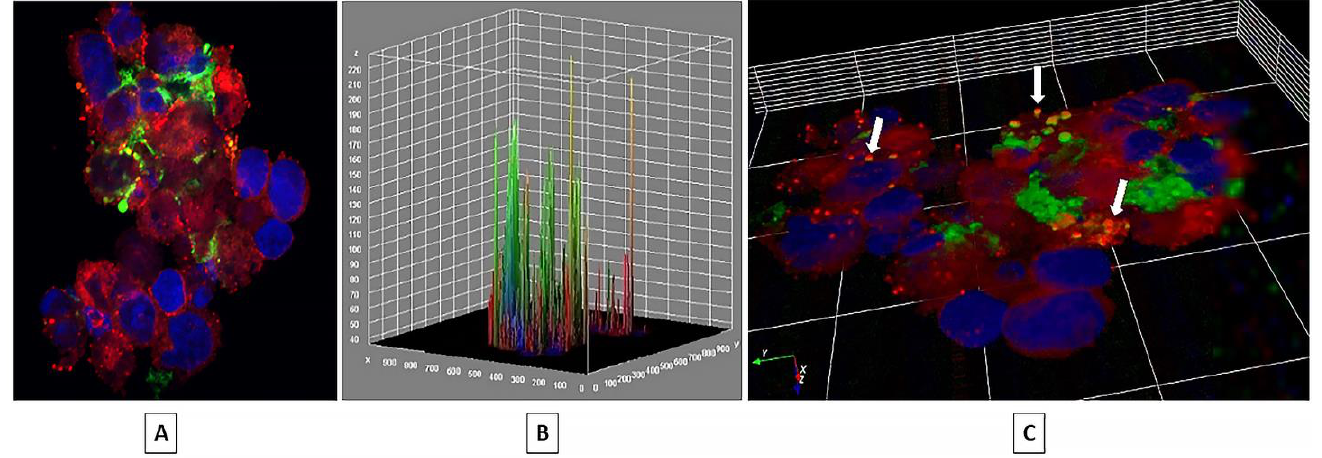
Figure 1. Composite Confocal image of a GBM cell cluster exposed to NSC-derived EVs. GBM cells are dyed with DiI, a lipophilic dye (Red). NSC EVs are green due to their parent cells being dyed with DiO, another lipophilic dye (Green). Nuclei are stained with DAPI (Blue) [33]. ( A ) A 2D image of the NSC EVs internalized in GBM cells. ( B ) A 3D Surface Plot of the same image created using ImageJ software. The yellow peaks represent the colocalization of the red signal from GBM cells and the green signal from the NSC EVs. ( C ) A 3D rendering of the image created using Icy, an open-source bioimage informatics platform [34]. The white arrows point to the colocalization signal of red and green colors indicating internalized